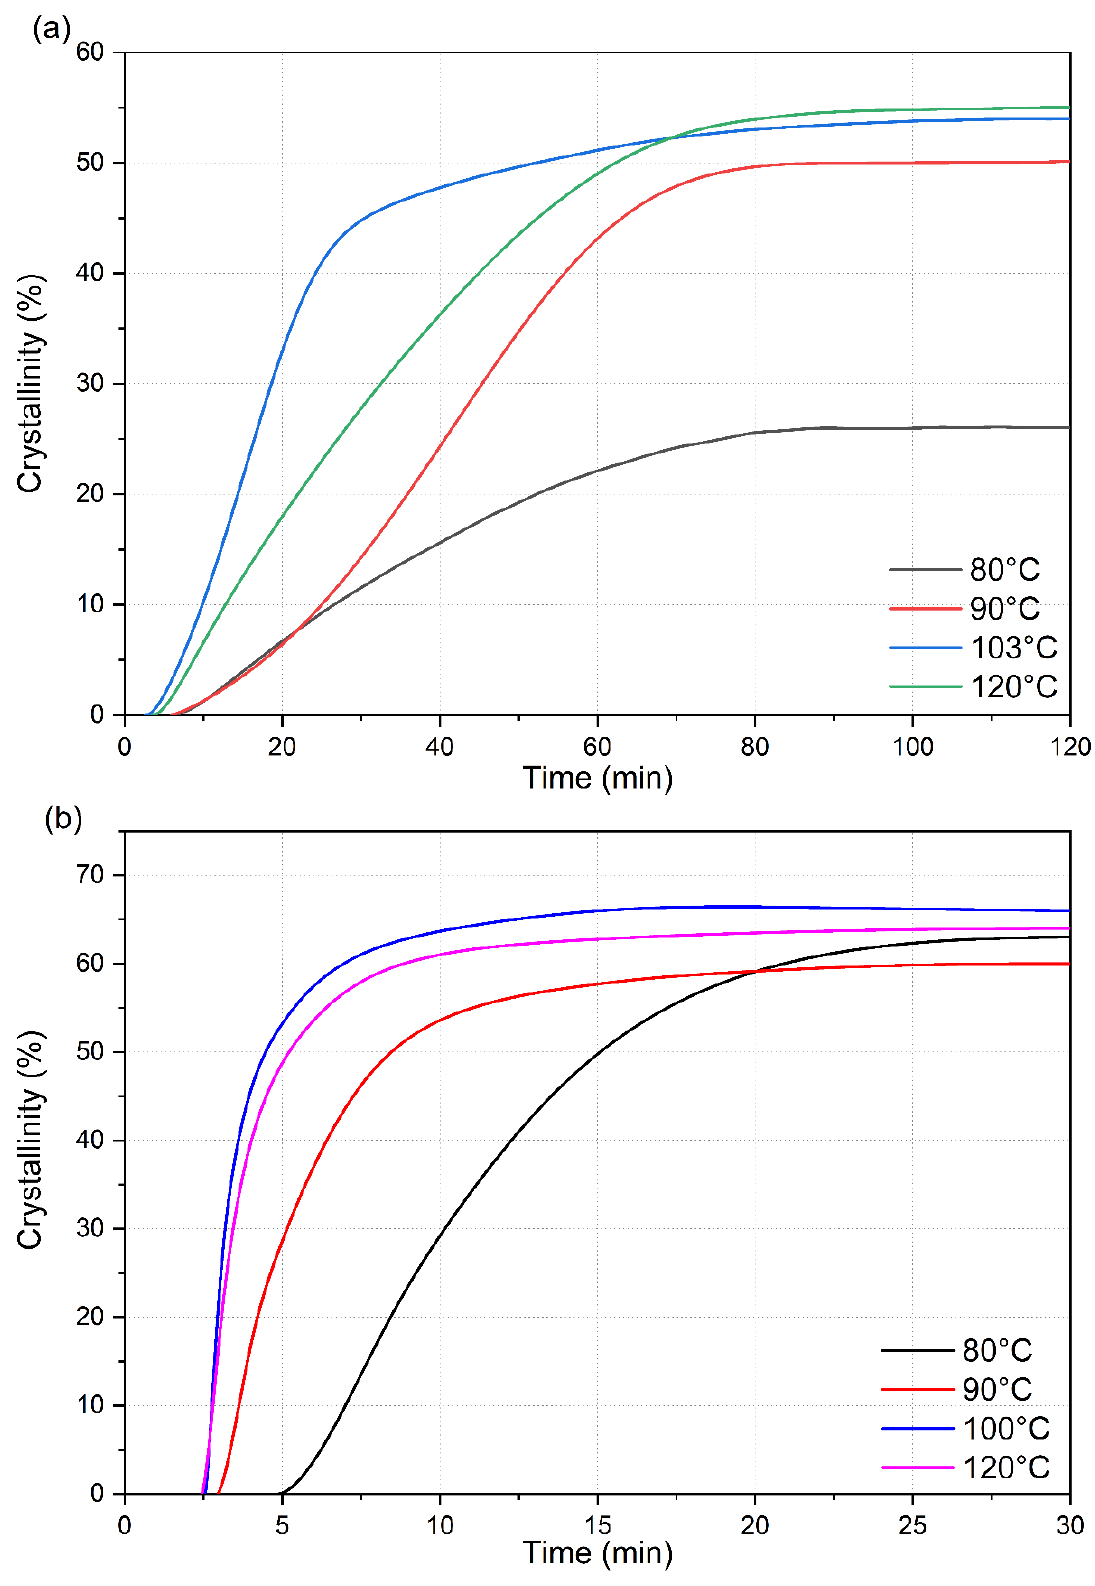
Figure 7. Crystallinity development of ( a ) neat PLA and ( b ) PLA-OA blend at different isotherm temperatures.